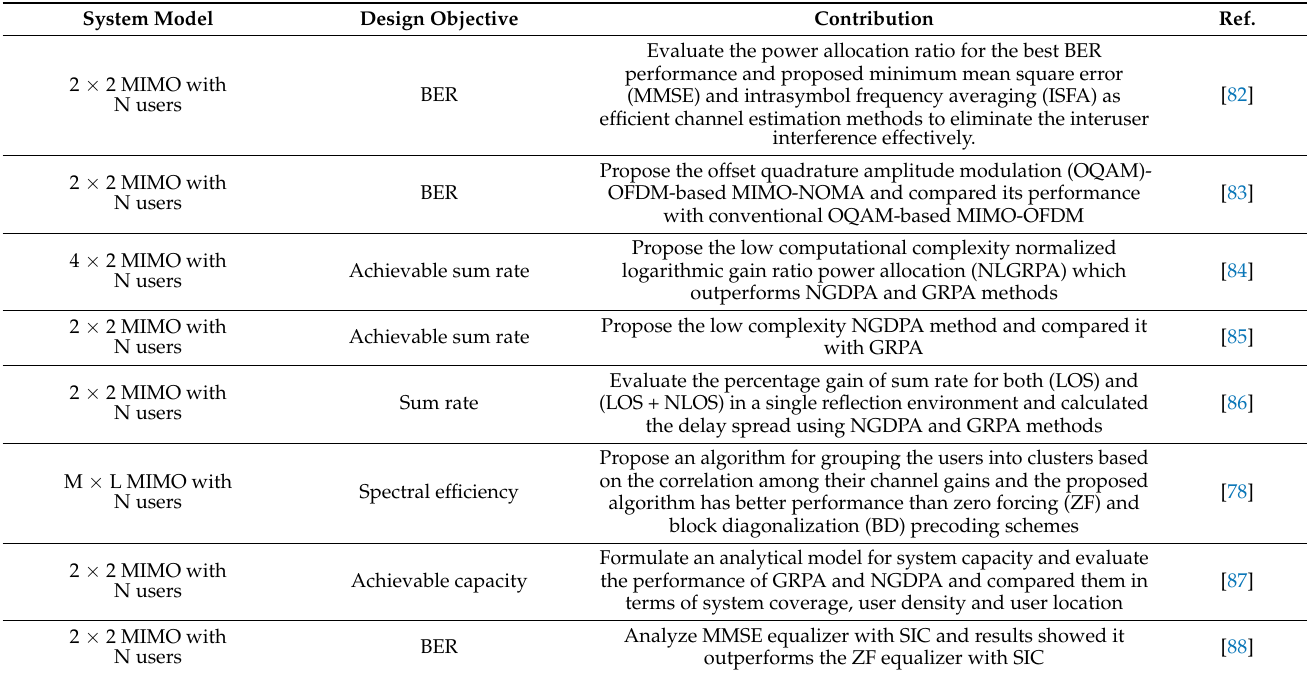
Figure 11. Block diagram of 2 × 2 MIMO-PD-NOMA-based VLC system with N users. Table 3. A summary of MIMO-PD-NOMA-based VLC